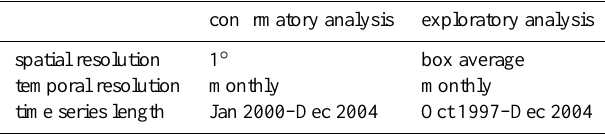
Table A1. Spatial and temporal characteristics of the input and tar- get data used in confirmatory and exploratory analysis.